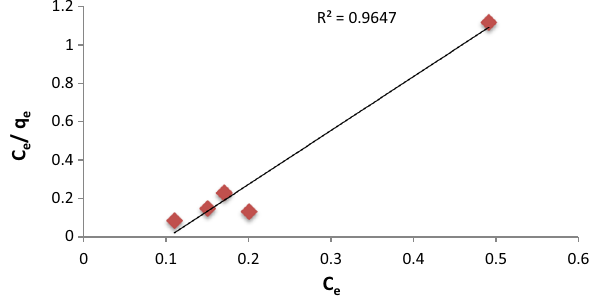
Fig. 9 Langmuir isotherm plot on sorption of Yokri crude oil onto